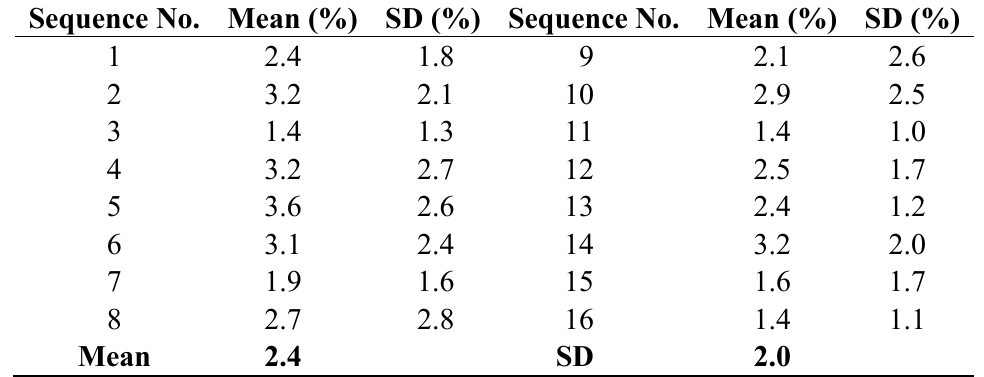
Each sequence contains 50 images. Resize factor = 1.6, s =